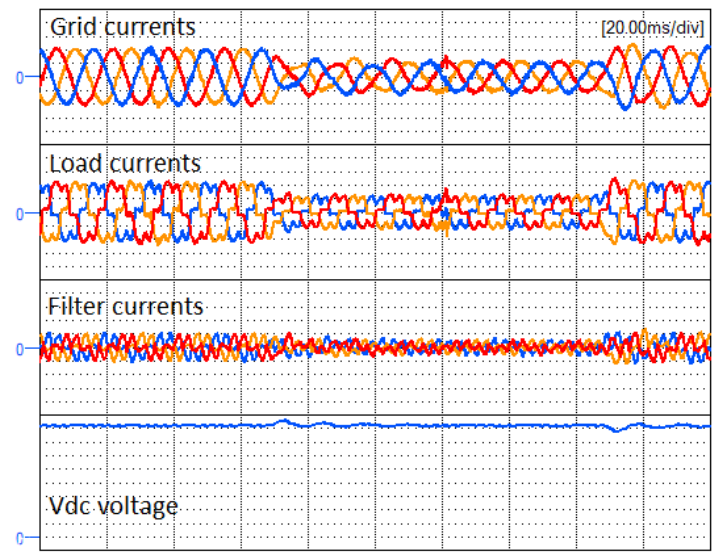
Figure 6. A sudden step change in the load from full-load to half-load and half-load to full-load. From top to bottom, grid currents (5 A/div), load currents (5 A/div), filter currents (5 A/div), output voltage (50 V/div).